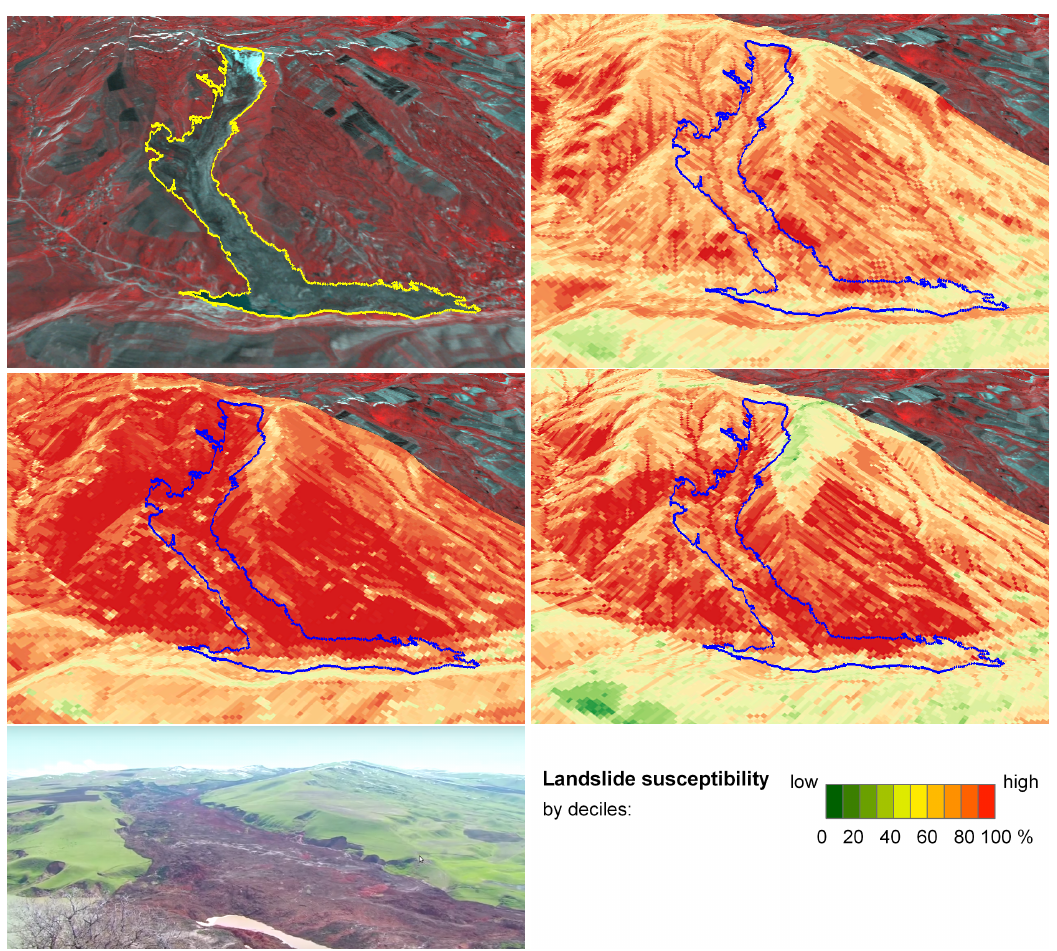
Figure 10. The 4.3-km-long Kurbu-Tash landslide that occurred in April 2017 (extent determined by automated detection) overlaid over a false-color near-infrared RapidEye image acquired on 2 May 2017 ( top left ). Overlay with the susceptibility map based on the highest points of automatically detected landslides ( top right ), masses of automatically detected landslides ( middle right ) and expert interpretation ( middle left ). ( Bottom left ): a video frame by AKIpress [40] acquired in the first half of May 2017 showing the landslide mass. Elevation data: Google